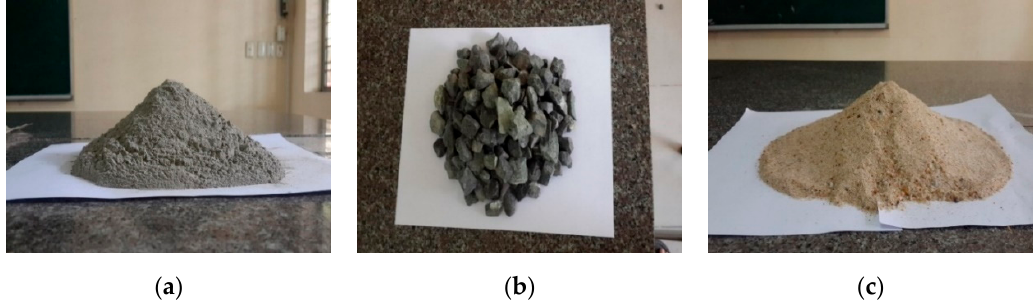
Figure 1. Materials used for experiment. ( a ) Fly ash, and ( b ) coarse aggregate, and ( c ) fine aggregate.